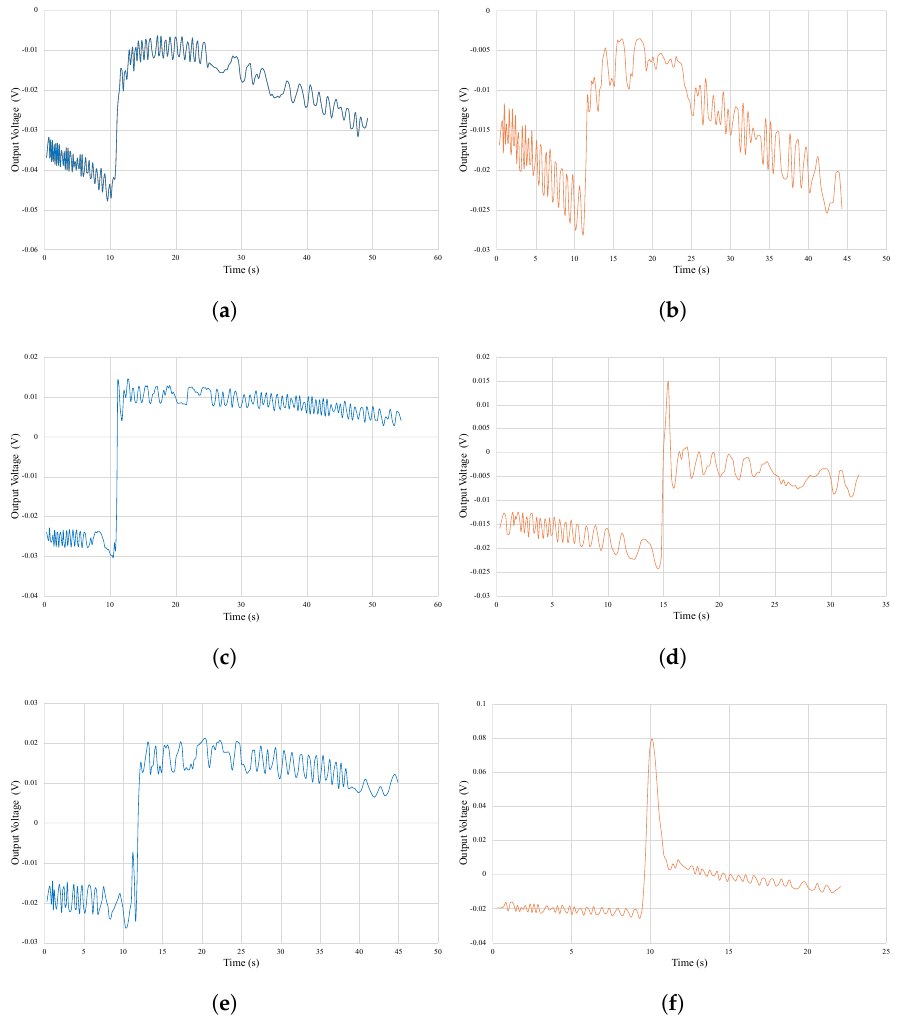
Figure 11. Output voltage change versus time for ∆ pH = 1 for the sample of ( a ) 20 nm, 300 °C, ( b ) 20 nm, 150 °C, ( c ) 40 nm, 300 °C, ( d ) 40 nm, 150 °C, ( e ) 80 nm, 300 °C, and ( f ) 80 nm, 150